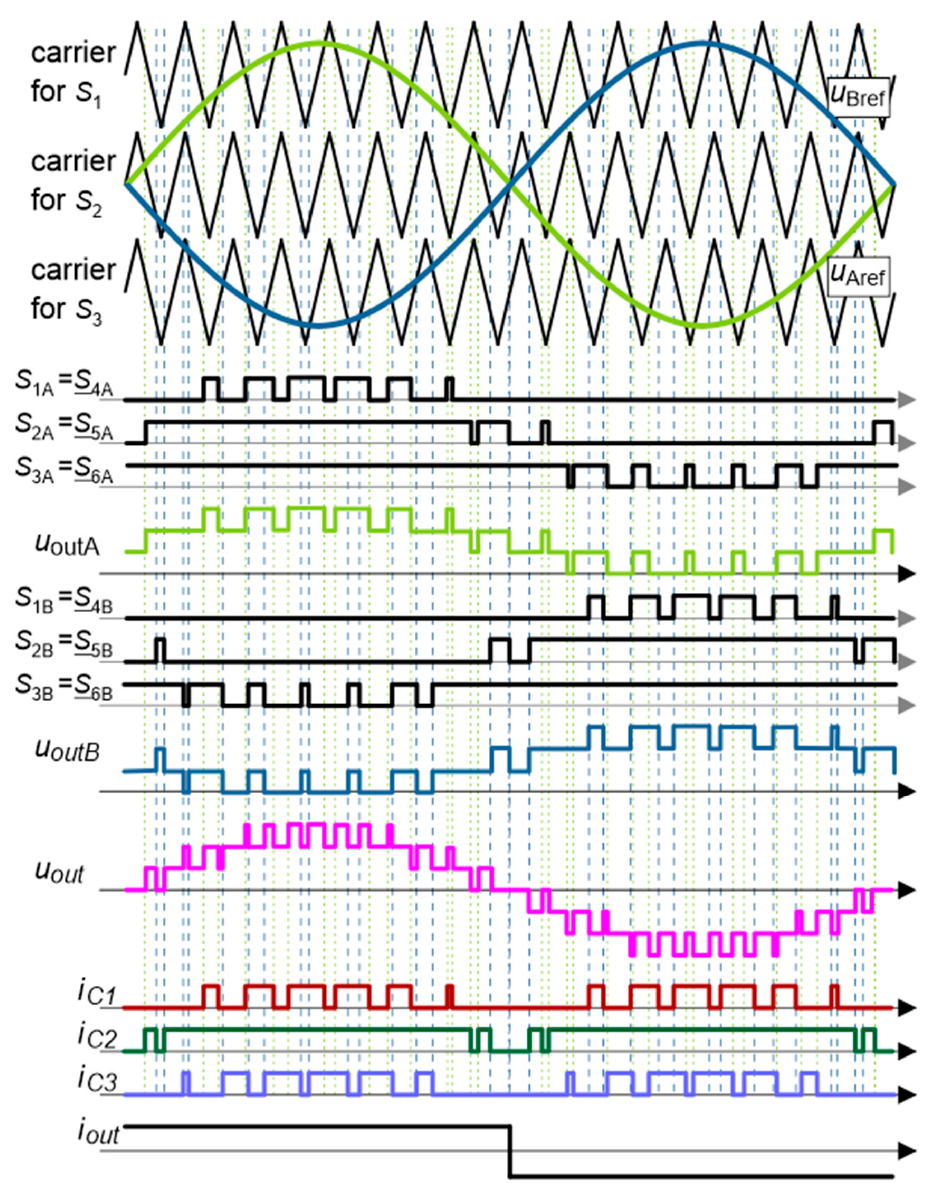
Figure 2. CBPWM and idealized waveforms in the seven-level inverter.